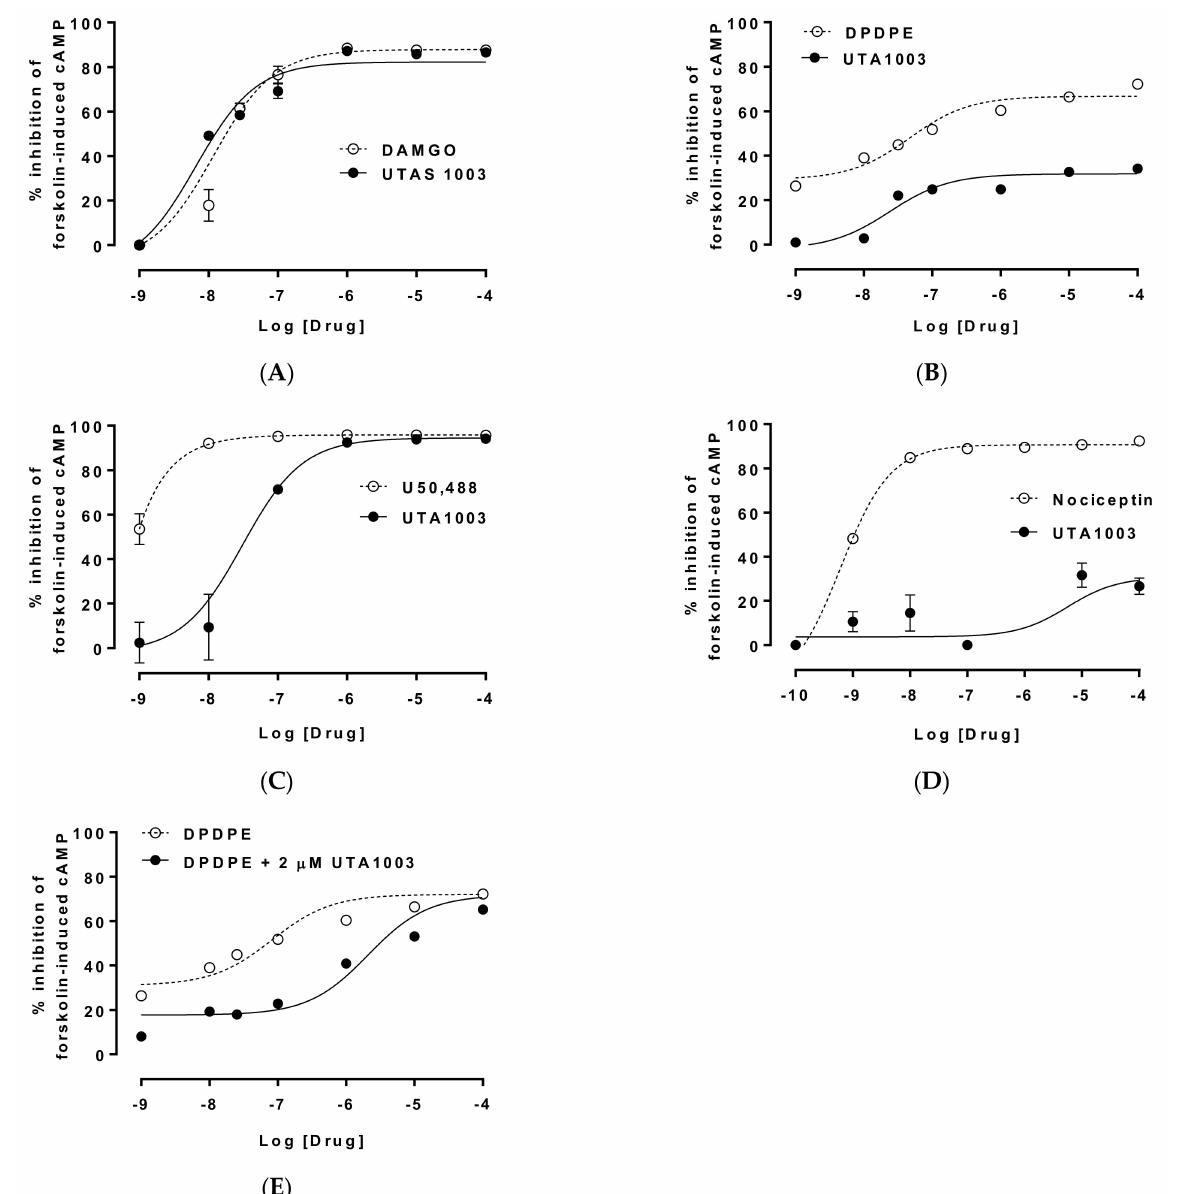
Figure 3. Dose-response of the agonistic effects of UTA1003 on different opioid receptors and antagonistic effect against the effect of DPDPE on DOP receptor. The MOP, DOP, KOP, and NOP receptor agonistic effects of UTA1003 were assessed as inhibition (%) of forskolin-stimulated cAMP levels in CHO cells expressing human MOP, DOP, KOP, or NOP receptor, respectively ( A – D ). The cAMP was stimulated using 1 µ M (5 µ M for KOP and NOP) forskolin. DAMGO (1 nM–100 µ M), DPDPE (1 nM–100 µ M), U50,488 (1 nM–100 µ M) or nociceptin (0.1 nM–100 µ M) was used as positive control. Different molar concentrations (M) of DPDPE (1 nM–100 µ M) vs. a combination of 2 µ